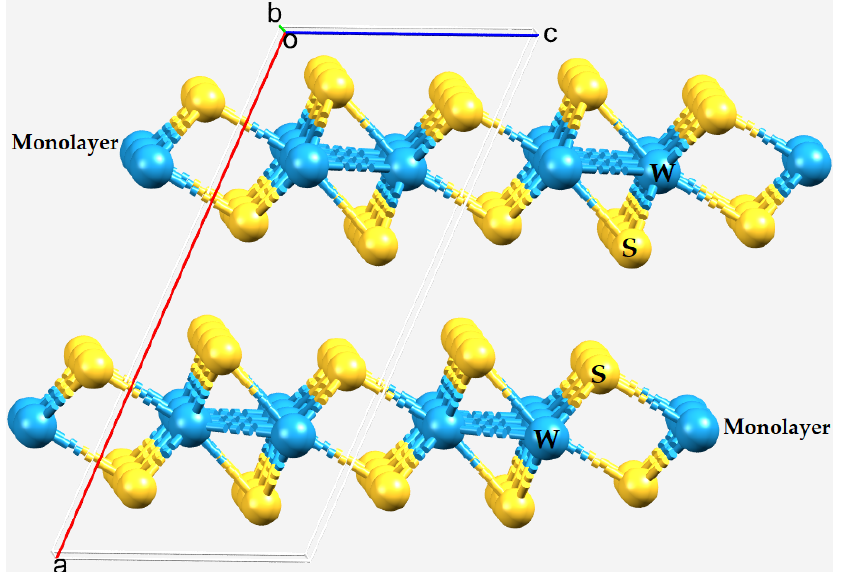
Figure 1. The bilayer structure of 2H-WS 2 (651384–ICSD [2]) viewed with the b -axis (slightly offset) perpendicular to the page. Atom type is shown.